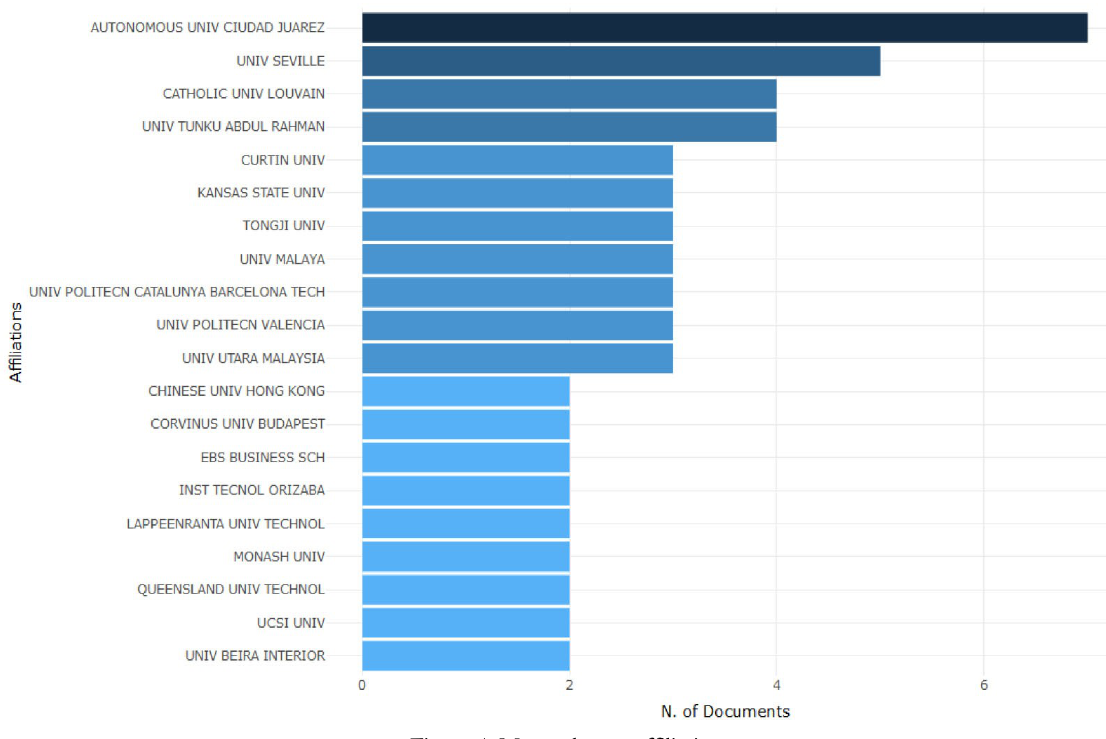
Figure 4. Most relevant affiliations